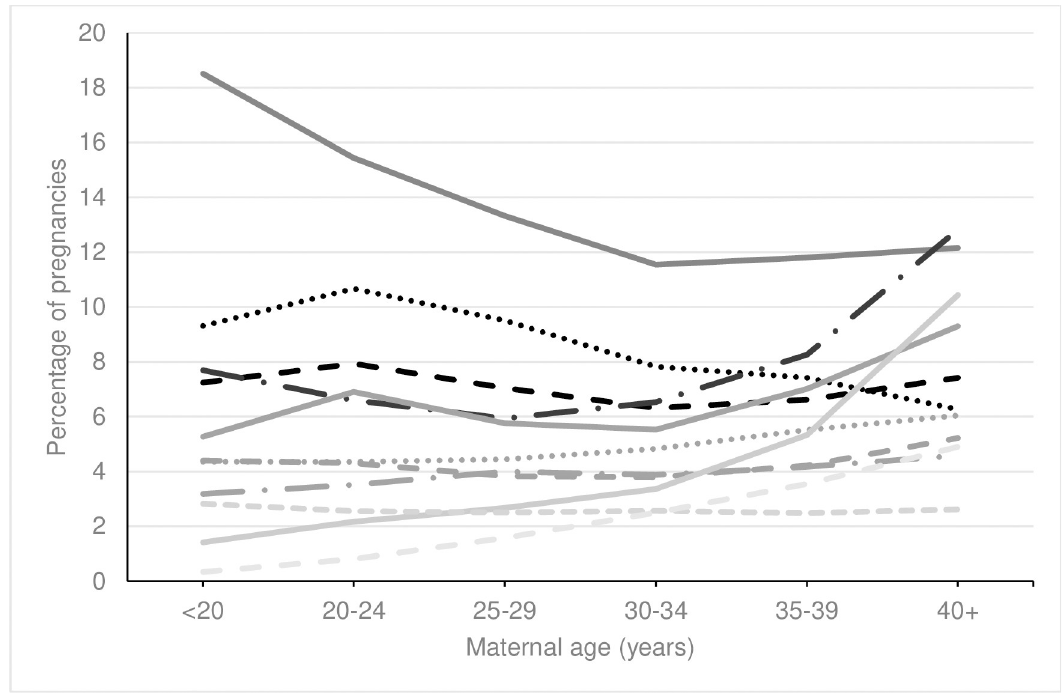
Fig 4. Percentage of pregnancies exposed to most common therapeutic classes of medication by maternal age. a Increasing trend (p < 0.001). Solid black line = antibiotics; Dotted black line = antiemetics; Dashed black line = analgesics; Long dashed black line = hormonal medications; Solid grey line = antidepressants; Dotted gey line = steroids; Dashed grey line = antiasthmatics; Long dashed grey line = laxatives a ; Solid light grey line = cardiovascular medications; Dotted light grey line = antihistamines; Dashed light grey line =